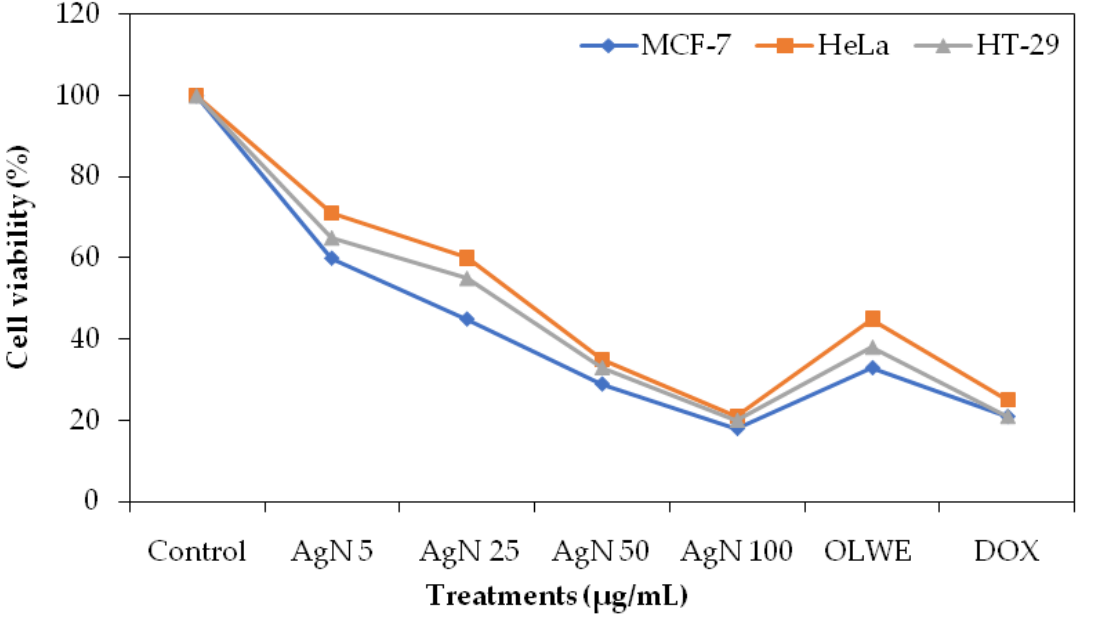
Figure 5. The cell viability percentage of three cancer cell lines (MCF-7, HeLa, HT-29) was affected by different concentrations of AgNPs, OLWE, and doxorubicin.